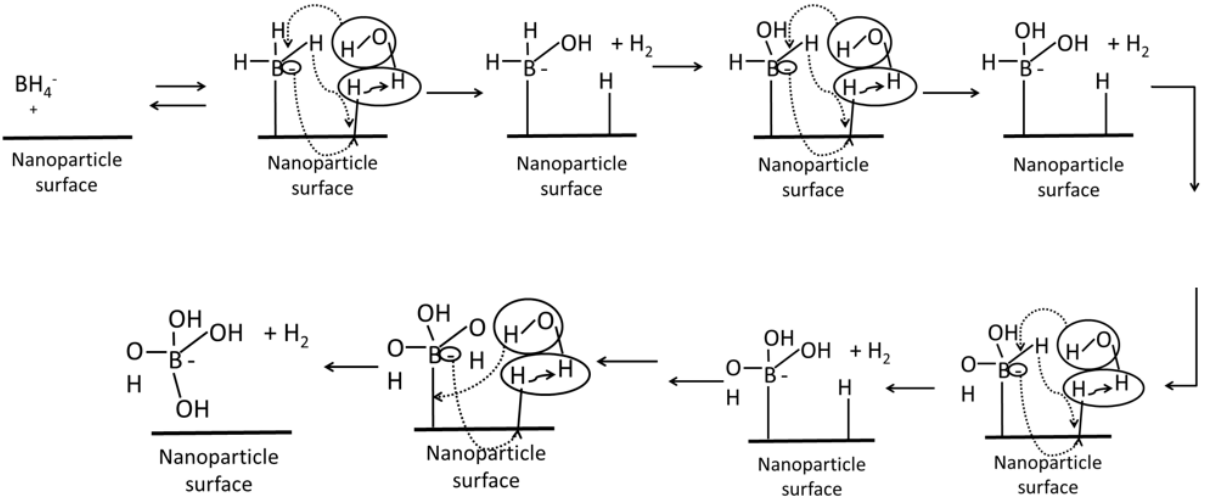
Figure 10. Catalytic reusability of BCD−AuNPs in the hydrolysis of sodium borohydride. Each trial ran for approximately 2 h under ambient